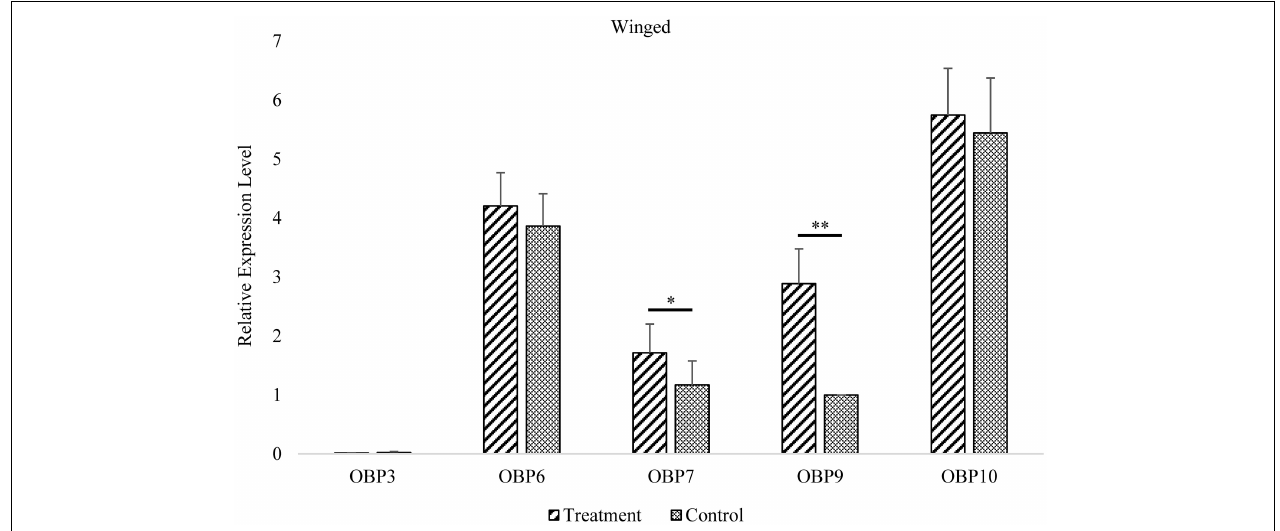
FIGURE 3 | Antennal OBP3/6/7/9/10 expression in the winged morph before and after EBF induction. Fold changes are relative to the antennal transcript levels of OBP9 in the winged morph before EBF induction. *Significant difference at the P = 0.05 level. **Significant difference at the P = 0.01 level (two-sample t -test). Winged, antennae of winged aphid; Treatment, EBF induction; Control, n-hexane control.